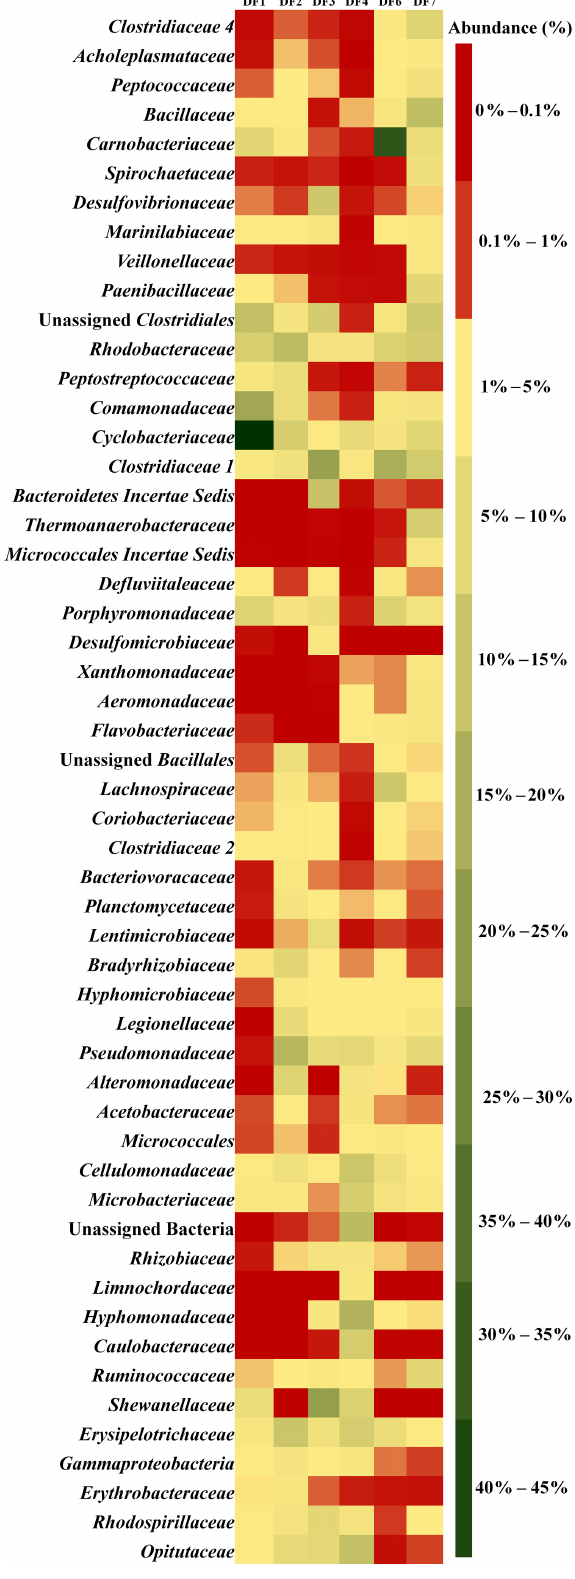
Figure 5. Microbial community composition and their abundance ( > 1%) in DF samples at family